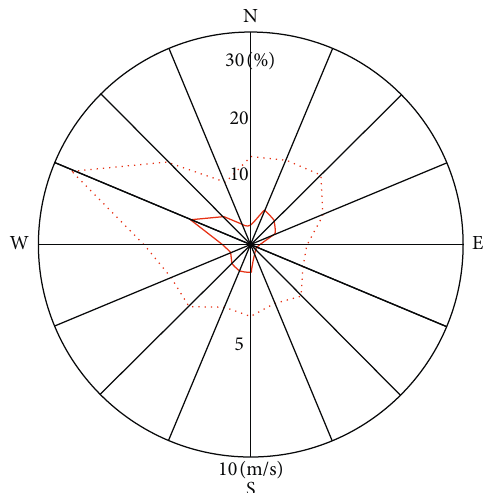
Figure 5: Wind rose for nine months from July 2014 to March